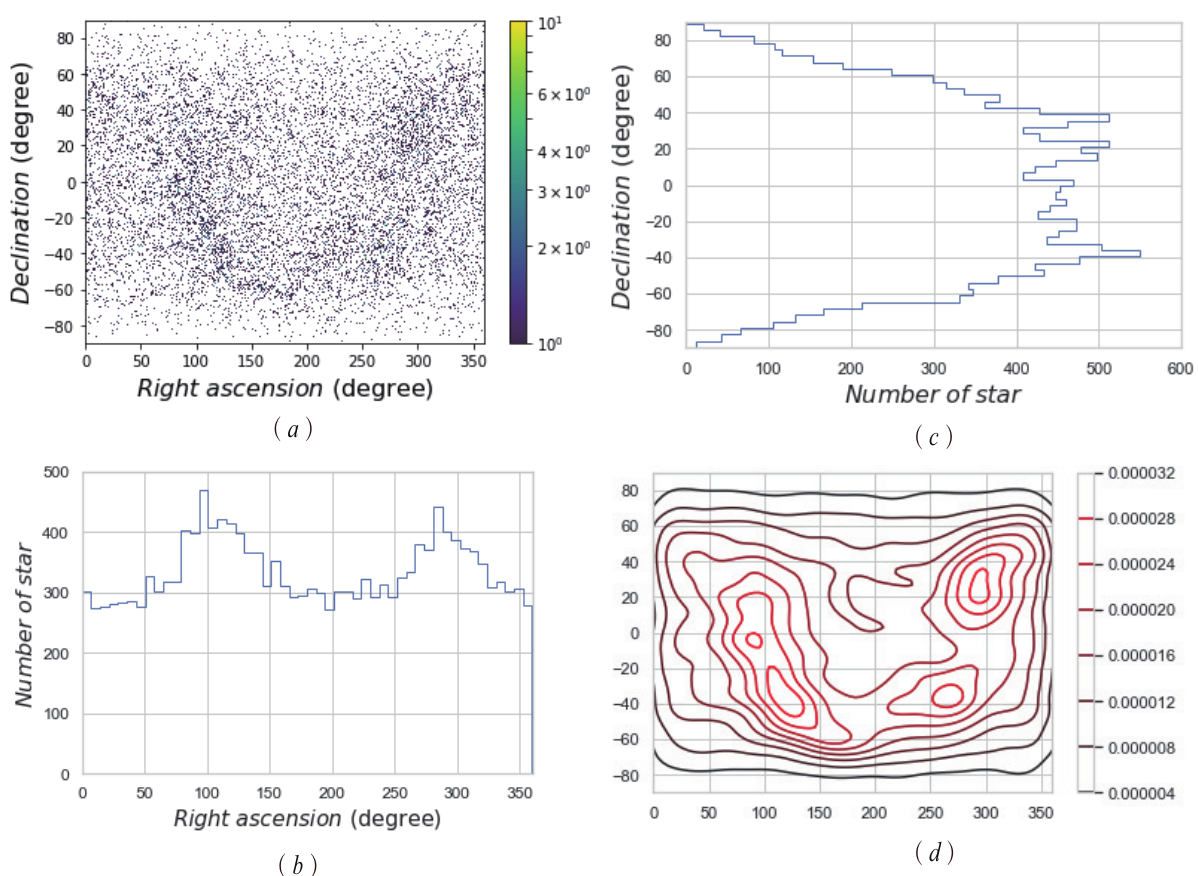
Figure 9. Uniformity and density of the K-Nearest Neighbours (KNN)-generated star catalogue. ( a ) The distribution density of KNN GSC; ( b ) the statistics of the NOS distributed in the direction of right ascension; ( c ) the statistics of the NOS distributed in the direction of declination; ( d ) the nuclear density line of KNN GSC stars in the celestial sphere. Table 2. Statistics of different guide star catalogues (GSCs) for a 12 ◦ × 12 ◦ FOV, tested in 10,000 random boresight directions. Classifier Total Guide